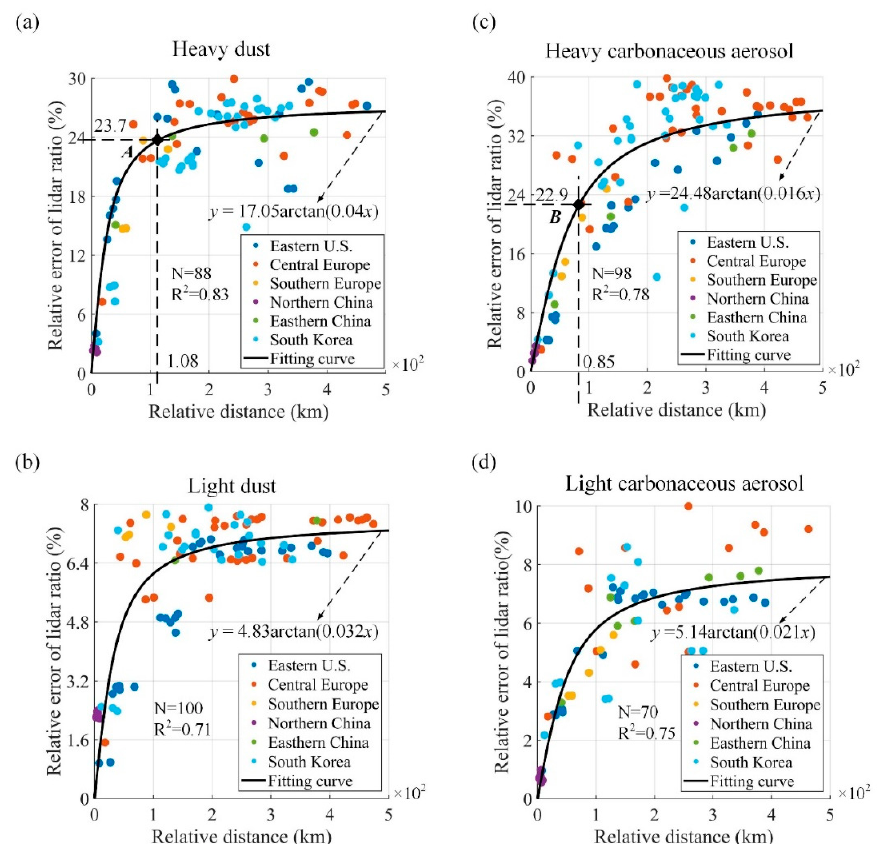
Figure 7. The scatter-fitting relationship between the relative distance and the relative error of the lidar ratio under different aerosol absorbing conditions. The six different scatter colors represent the lidar ratio average relative error between any two sites in the six regions of the eastern US, northern Europe, northern Europe, northern China, eastern China, and South Korea. The solid black line represents the fitting curve, and N and R 2 represent the total number of fitting points and the coefficient of determination for the six regions, respectively. ( a ) Under the condition of heavy dust, point A represents the intersection of the lidar ratio relative error of 23.7% and the relative distance of 108 km; ( b ) Under the condition of light dust; ( c ) Under the condition of heavy carbonaceous aerosols, point B represents the intersection of the lidar ratio relative error of 22.9% and the relative distance of 85 km; ( d ) Under the condition of light carbonaceous aerosols. The dashed line in the subplot points to the equation of the fitted curve.